Question: Name the type of graph shown.
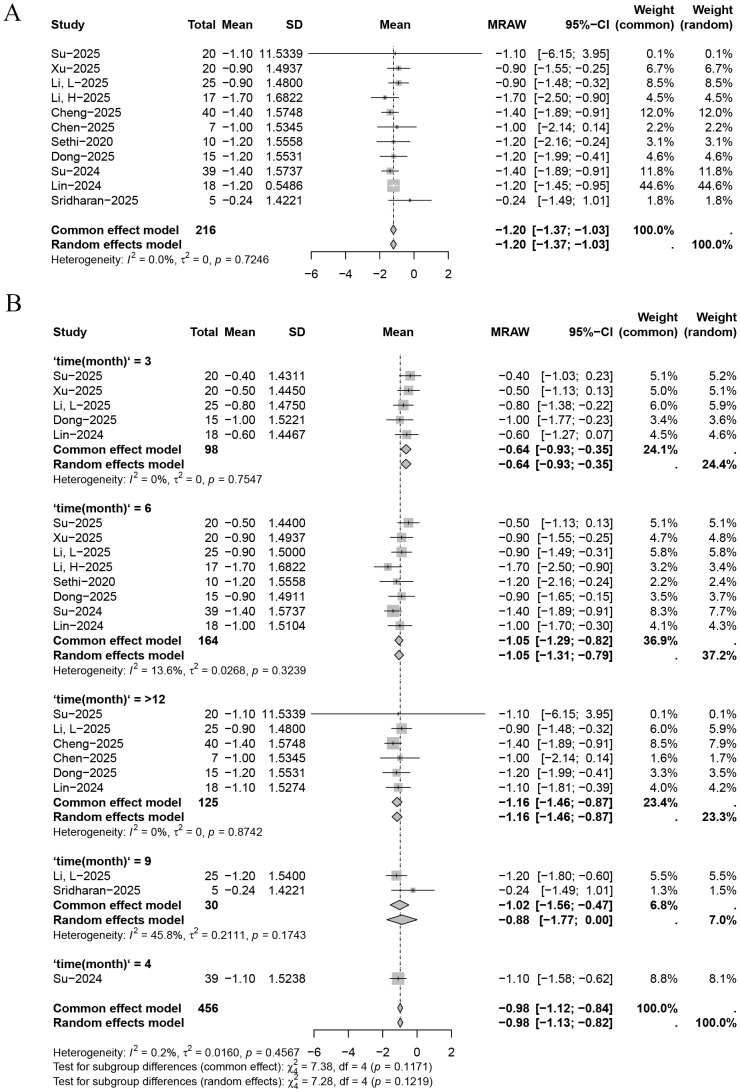
Answer: forest